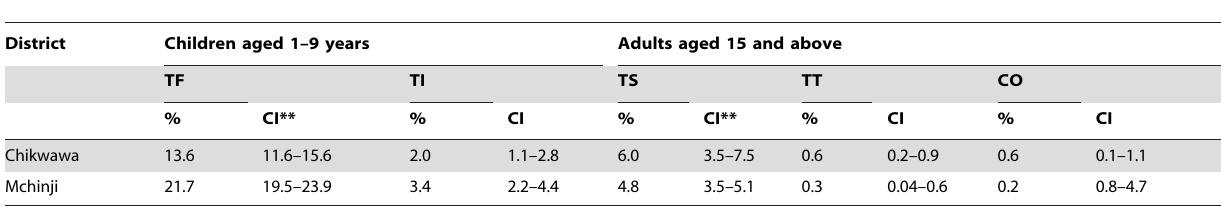
Table 3. Prevalence rates for Trachoma* in Chikwawa and Mchinji districts.